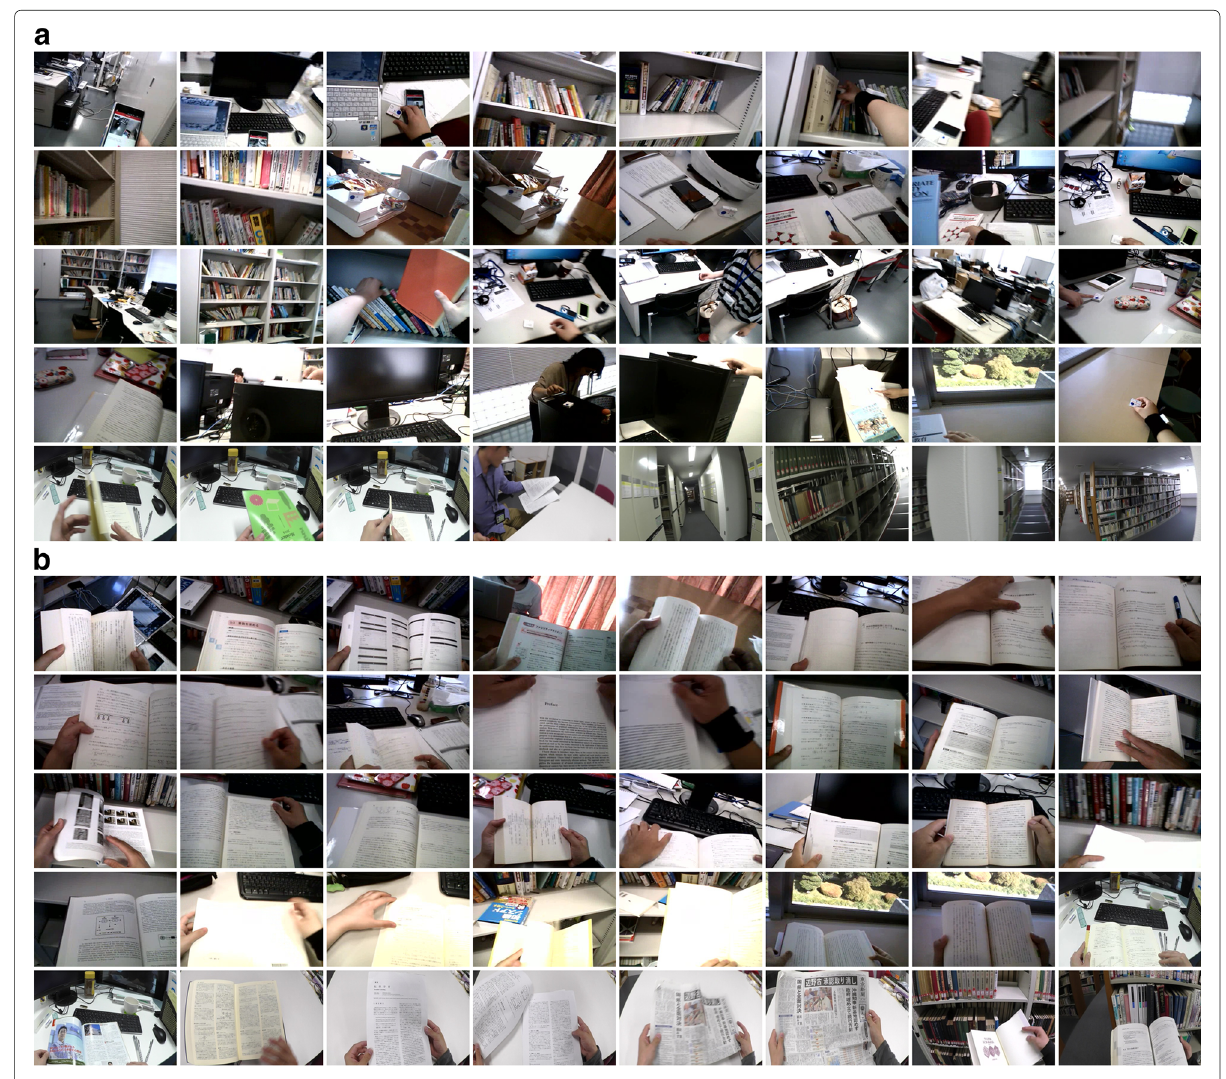
Fig. 6 Example images of 20 videos for test. a “Others” class. b “Reading”